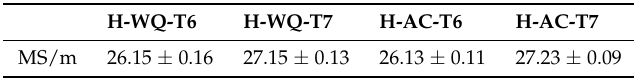
Table 3. Electrical conductivity measurements of the four studied conditions, represented by the average value and standard deviation of five independent